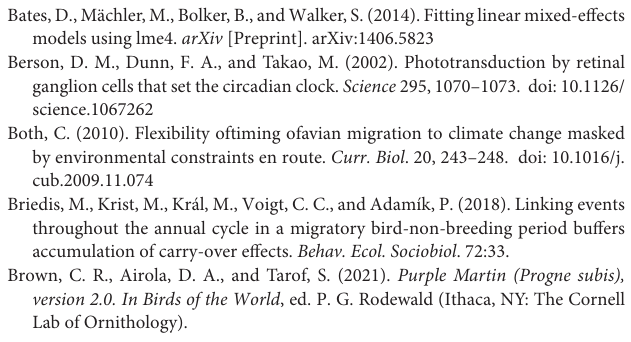
Supplementary Figure 1 | Schematic of the ALAN treatment. 5 lux of artificial white or green light were turned on at sunset and off at sunrise. Supplementary Figure 2 | The panel shows detection data from a Motus receiver station for an individual bird. The colors represent various antennae at the station. Signal strength shows fledging date and time for hatch-year purple martin (first stage of post-fledging movement), with the initiation of fledging on July 24th, at 21:16 GMT and departure from the colony (second stage of post-fledging movement) on July 28th, at 12:00 GMT. The blank spaces demonstrate the moments that the bird left the vicinity of the tower. The signal strength before fledge date shows the time that the bird spent in the